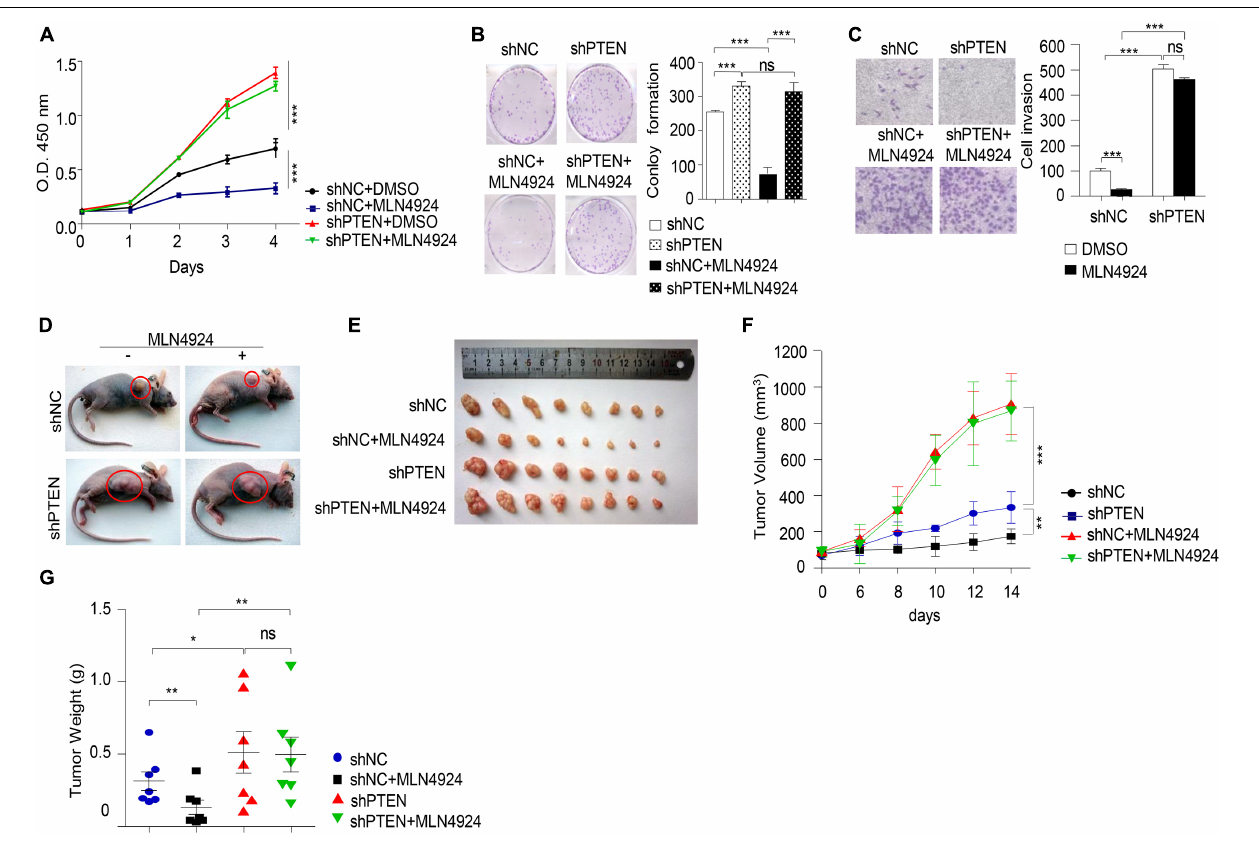
FIGURE 4 | MLN4924 via PTEN to inhibit tumorigenesis. (A–C) Cell proliferation assay (A) , colony formation assay (B) , and cell migration assay (C) were analyzed in MCF-7 cells with the depletion of PTEN by shRNA. Cells were treated with 1 µ M MLN4924 for 12 h before harvest. All data were representative of three independent experiments. Data shown are mean ± SD, n = 3 independent experiments. Image J was used to perform quantitative analysis. (D–G) Nude mice were injected subcutaneously for each of the indicated stable cell lines. Nude mice were treated with normal saline or MLN4924 (10 mg/kg i.p.) twice a day for 4 weeks. The transplanted tumors were removed and photographed (D,E) . Tumor volumes (F) and weights (G) were measured. Tumor weights and volumes are presented as mean ± SD; * P < 0.05, ** P < 0.01, *** P <